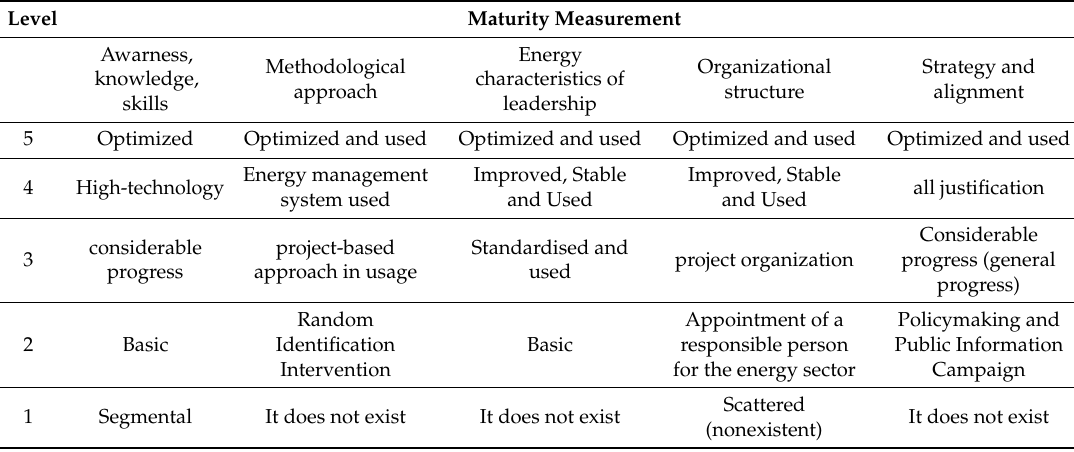
Table 8. Levels and dimensions of maturity in